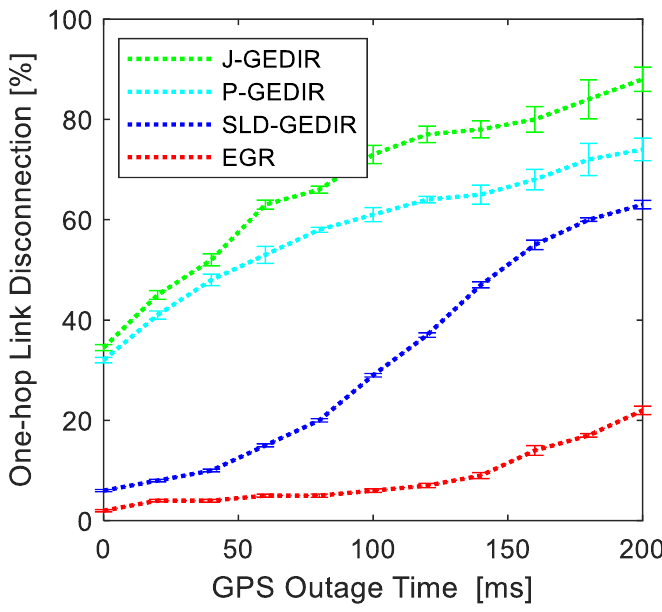
Figure 10. Effect of GPS outage on one-hop link